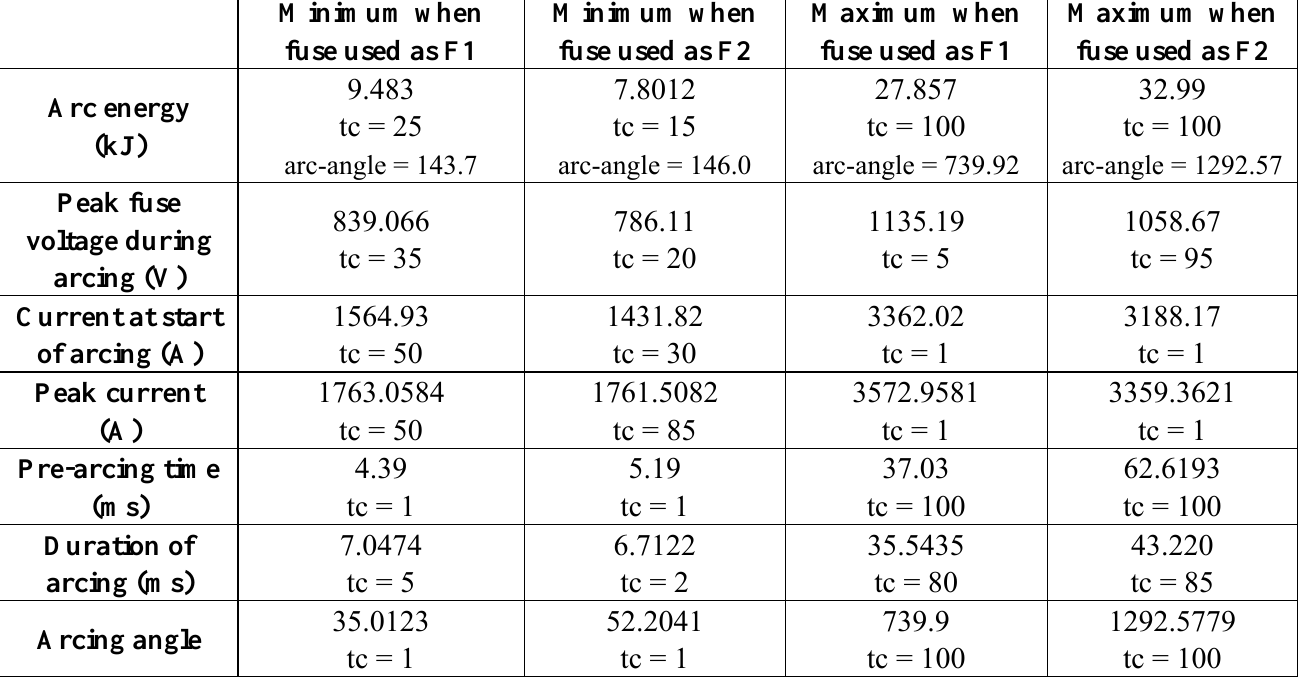
Table 2. Lists of the minimum and maximum values for arc energy, peak fuse voltage, the current at start of arcing, peak prospective current, pre-arcing time, arcing duration, arc- angle and the time constant at which the minimum and maximum